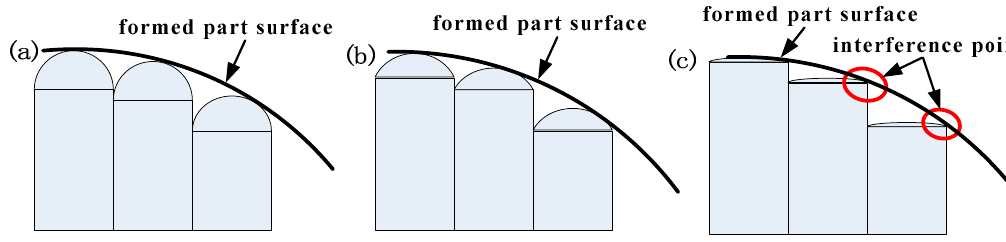
Figure 2. Multi-point dies with different ball head radius: ( a ) small ball head radius; ( b ) large ball head radius; ( c ) ultra-large ball head radius.